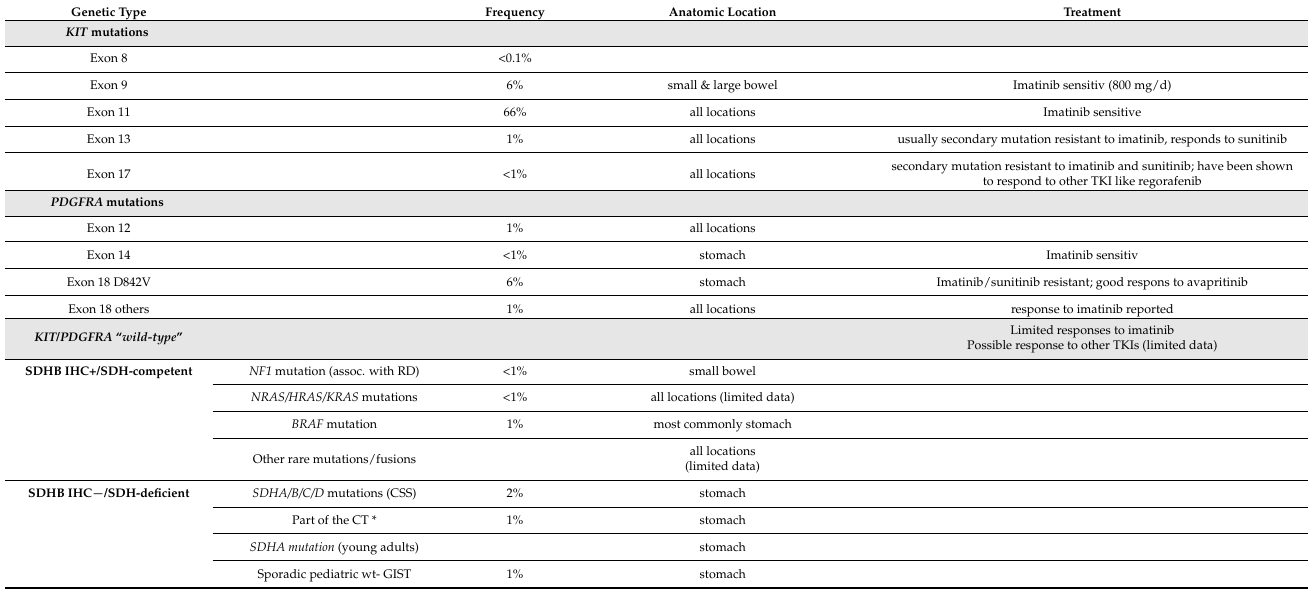
Figure 2. Sub-classification of GISTs into a succinate dehydrogenase (SDH)-competent and an SDH-deficient group by using an SDHB IHC # . Legend: CSS: Carney–Stratakis Syndrome; CT: Carney triad; CT *: in some cases, mutations described [9]; wt: wild type. Grey rectangle: DNA- and RNA sequencing in a specialized center. Table 2. Anatomic distribution, frequency and treatment response of the most common GISTs